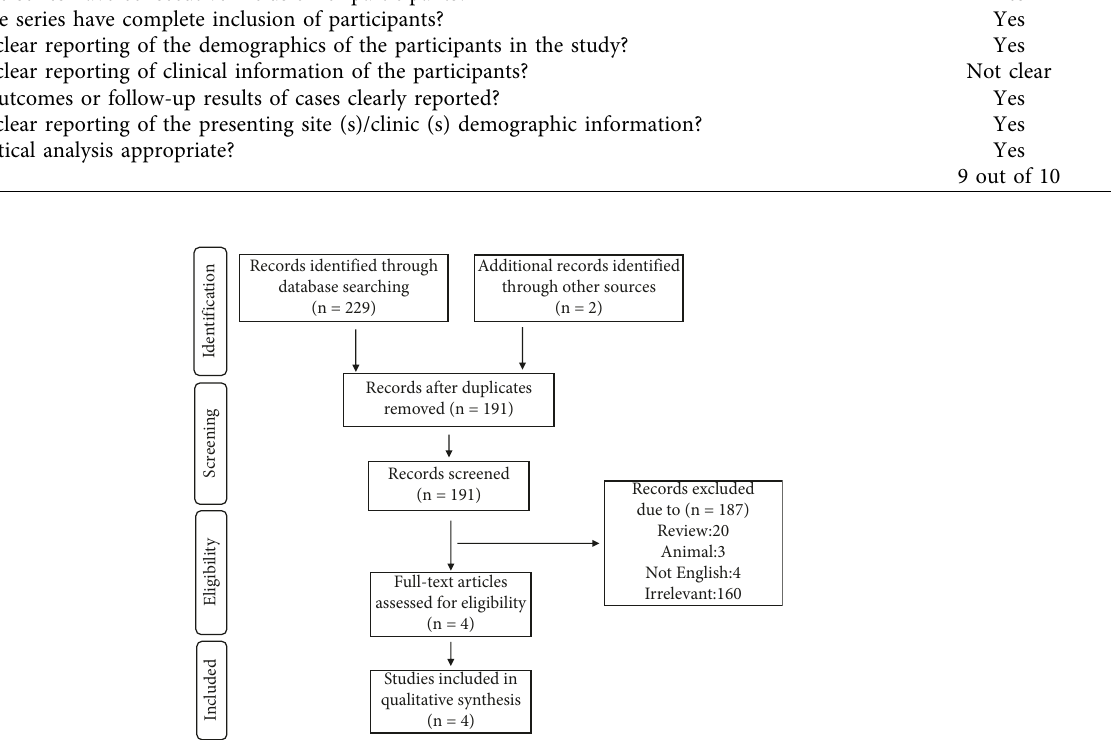
Figure 1: PRISMA flow diagram: includes details our search and selection process applied during the systematic